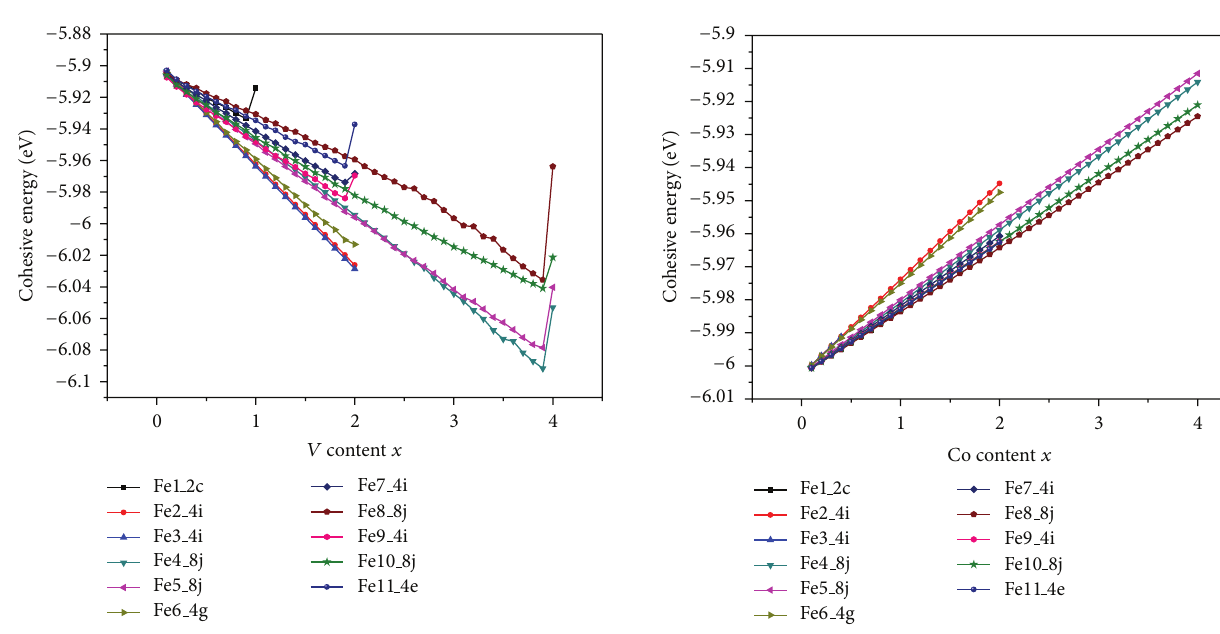
Figure 3: Calculated cohesive energy of Tb 3 Fe 27.4−𝑥 Co 𝑥 V 1.6 as a function of the Co content 𝑥 Fe corresponding to 3 29